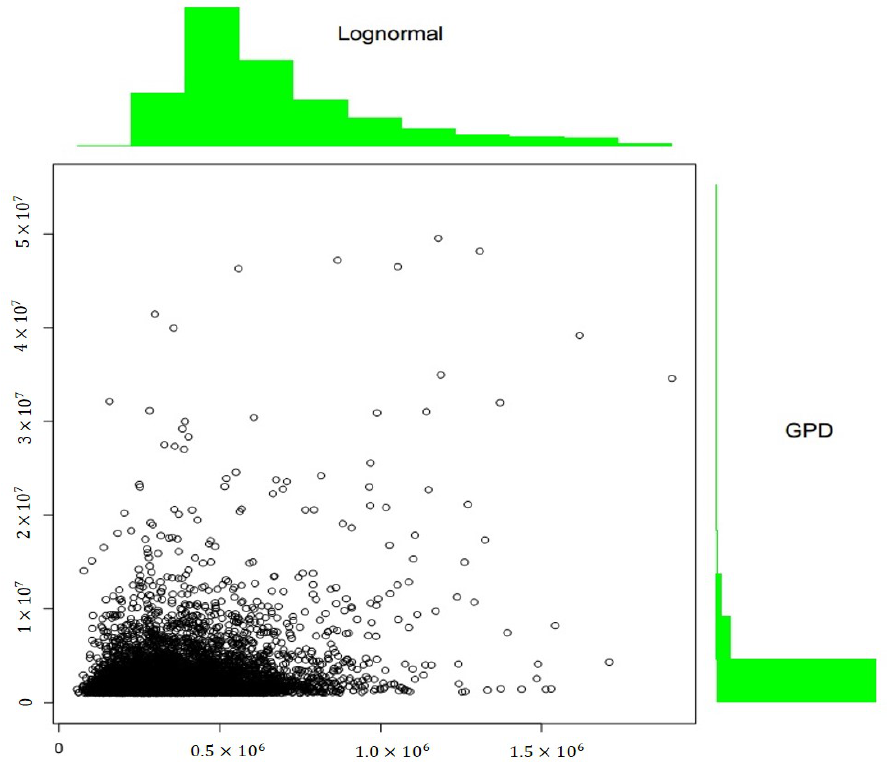
Figure 11. Lognormal (top) and GPD (right) marginal histograms and Gumbel Copula simulated values plot.